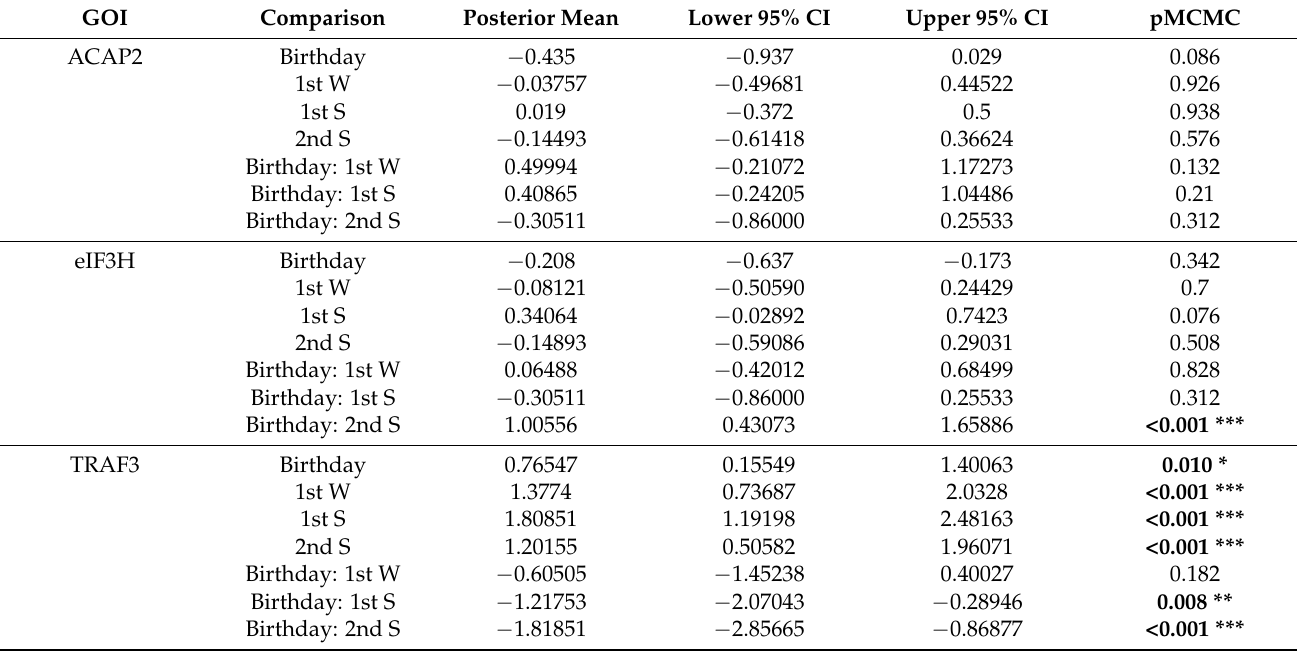
Table 4. Two-way factorial mixed effects model for transplant site-dependent and seasonal effects on transcript abundance of Porites astreoides following reciprocal transplantation between an inshore patch reef (Birthday Reef) and offshore bank reef (Acer 24). The results for the three genes of interest (GOI) adenylate cyclase associated protein 2 (ACAP2), eukaryotic initiation factor 3 subunit H (eIF3H), and TNF receptor associated factor 3 (TRAF3) are presented. Comparisons have been made to transcript abundances of samples transplanted to Acer24 Reef and sampled during the 2ndW. Note: First summer (1st S) and winter (1st W) vs. second summer (2nd S) and winter (2nd W) are shown. Asterisks indicate level of significance: